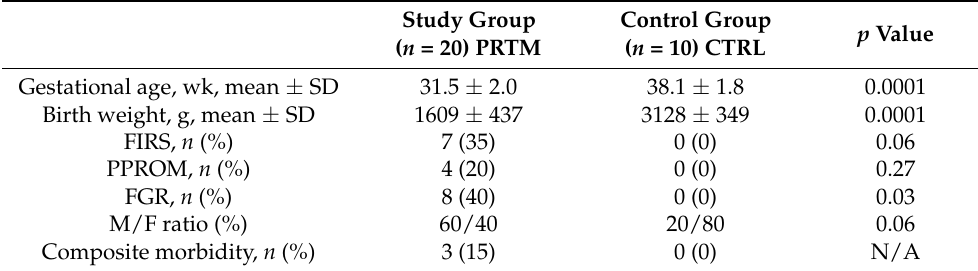
Table 1. Description of the experimental